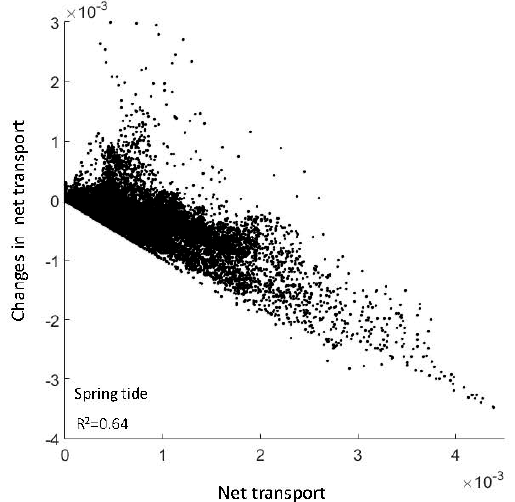
Figure 5. Cumulative frequency-magnitude distribution of net transport (m 3 /s/m) values across the entire domain (adapted from Leonardi and Plater [60]).